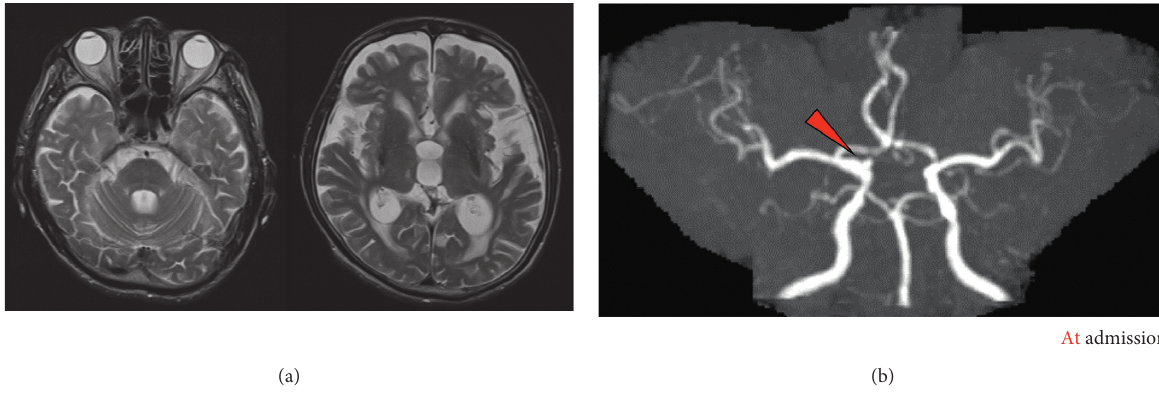
Figure 2: On admission: brain MRI showing no abnormalities in the cerebraand parenchyma on T2-weighted images (a). MRI shows a 3 mm aneurysm in the siphon of the internal carotid (arrow head) (b).